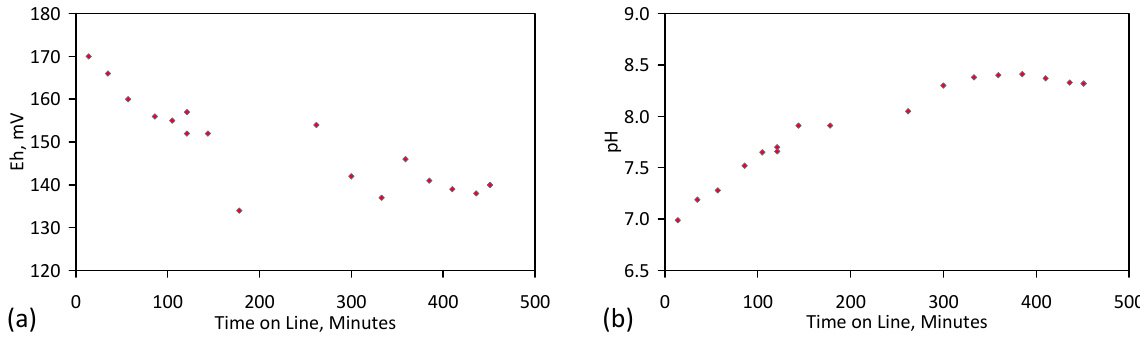
Figure C25. ZVM TPA example Trial E146. 5th Reuse; Operating Temperature: 17–23 °C; Oxidising Environment: Water volume in the reactor = 0.24 m 3 ; ZVM TPA from Trial E145 in a cartridge = 0.4 kg; Air flow = 120 L·h − 1 . ( a ) Eh vs. time; ( b ) pH vs. time; ( c ) pH vs. Eh; ( d ) Salinity vs. time; ( e ) Salinity calculated from normalised data vs. salinity calculated from raw data; ( f ) EC vs.